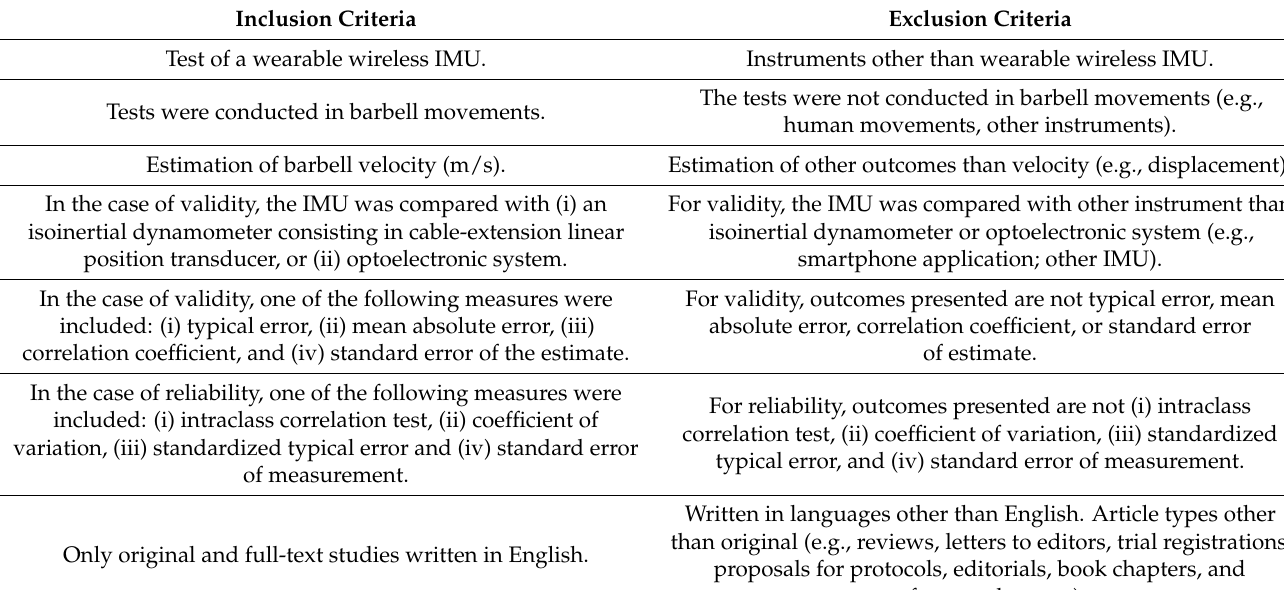
Table 1. Eligibility